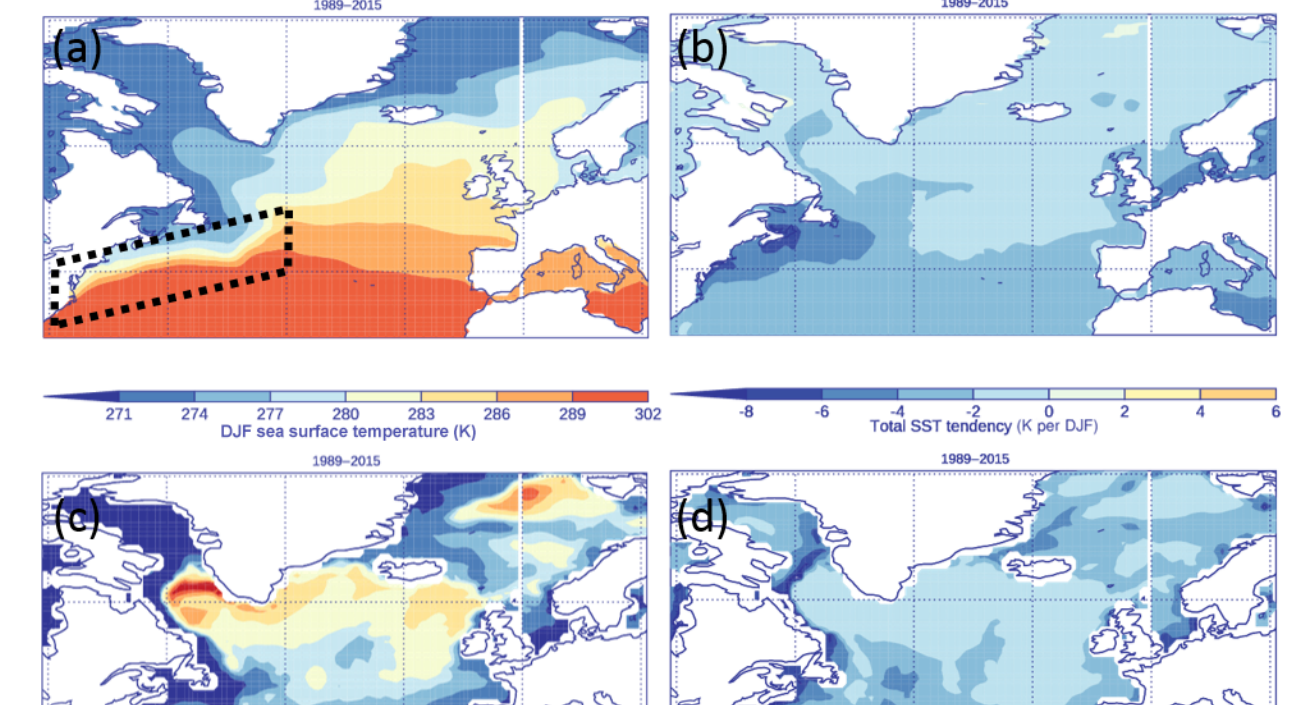
(K per DJF), and (e) difference between (cid:49) SST TOT and (cid:49) SST Q N